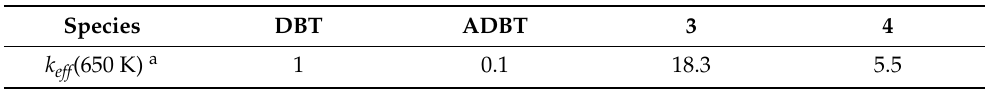
Table 3. Thermal stability of the dinitrobenzotriazoles and dinitrotriazolopyridines: the effective rate constants of C–NO 2 bond scission. Species DBT ADBT 3 4 k eff (650 K) a 1 0.1 18.3